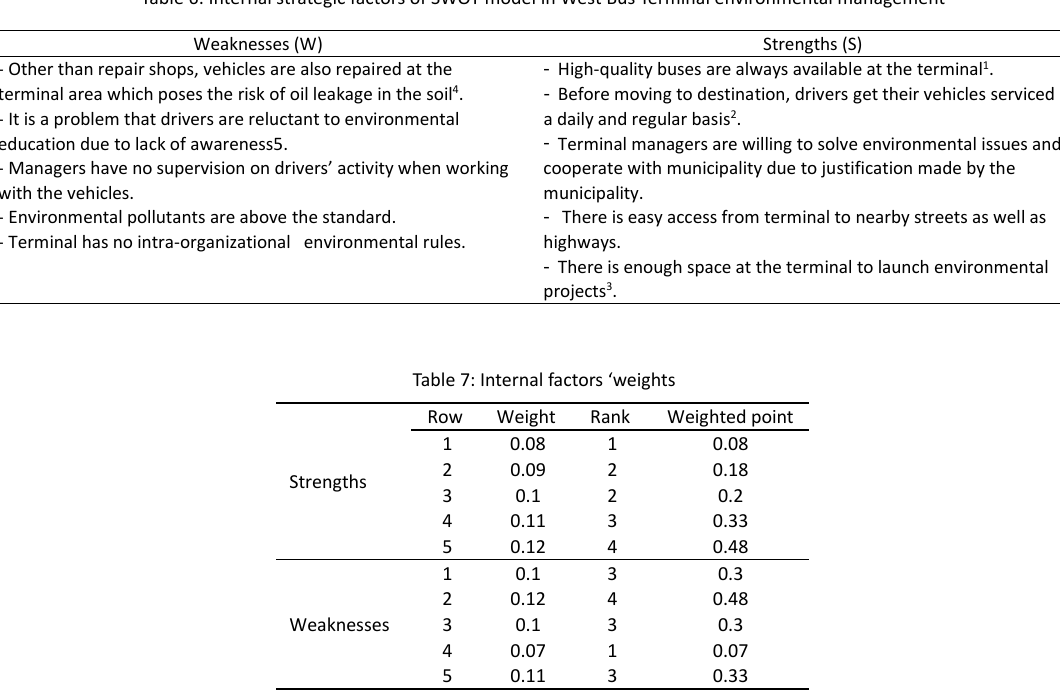
Table 6: Internal strategic factors of SWOT model in West Bus Terminal environmental management